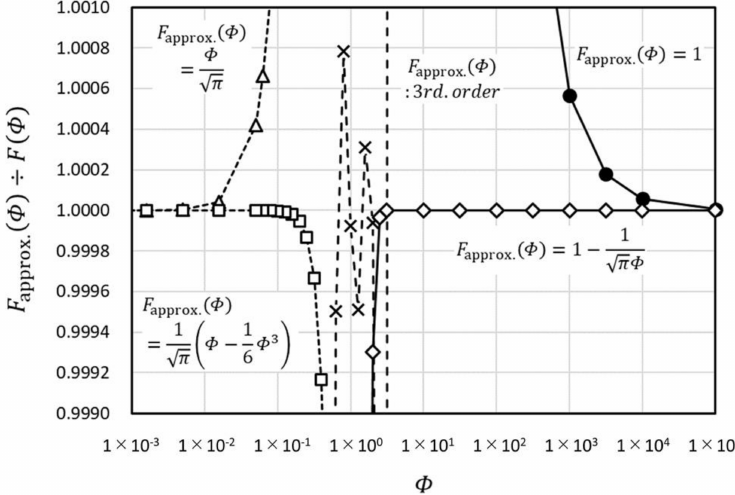
Figure 3. Comparison of the relative approximation error with various approximation